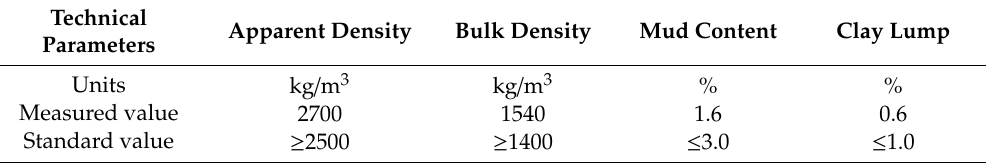
Table A3. Technical parameters of